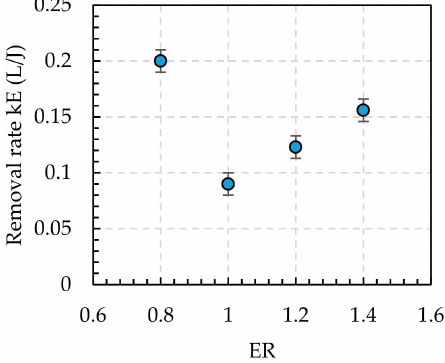
Figure 5. NO removal e ffi ciency k E as a function of